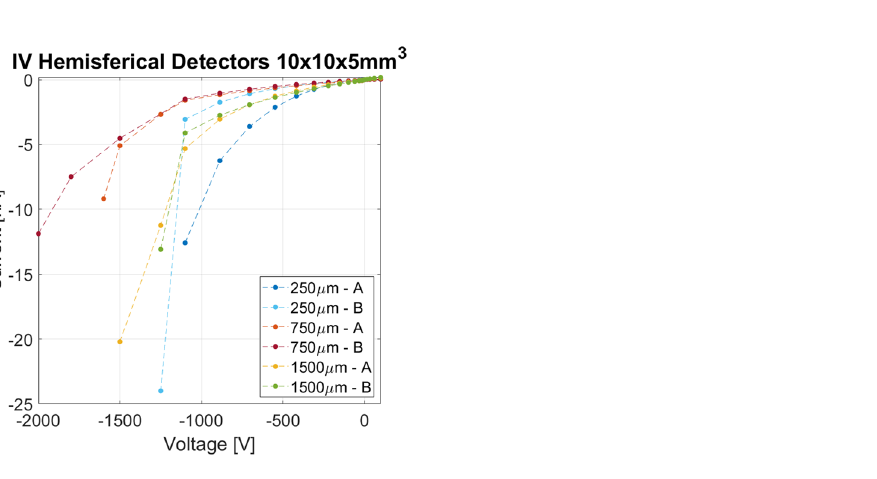
Figure 5. Current–voltage curves for the six fabricated detectors. Absolute current values increase more rapidly for the sensor that was damaged during the process. Measurements were carried out at 20